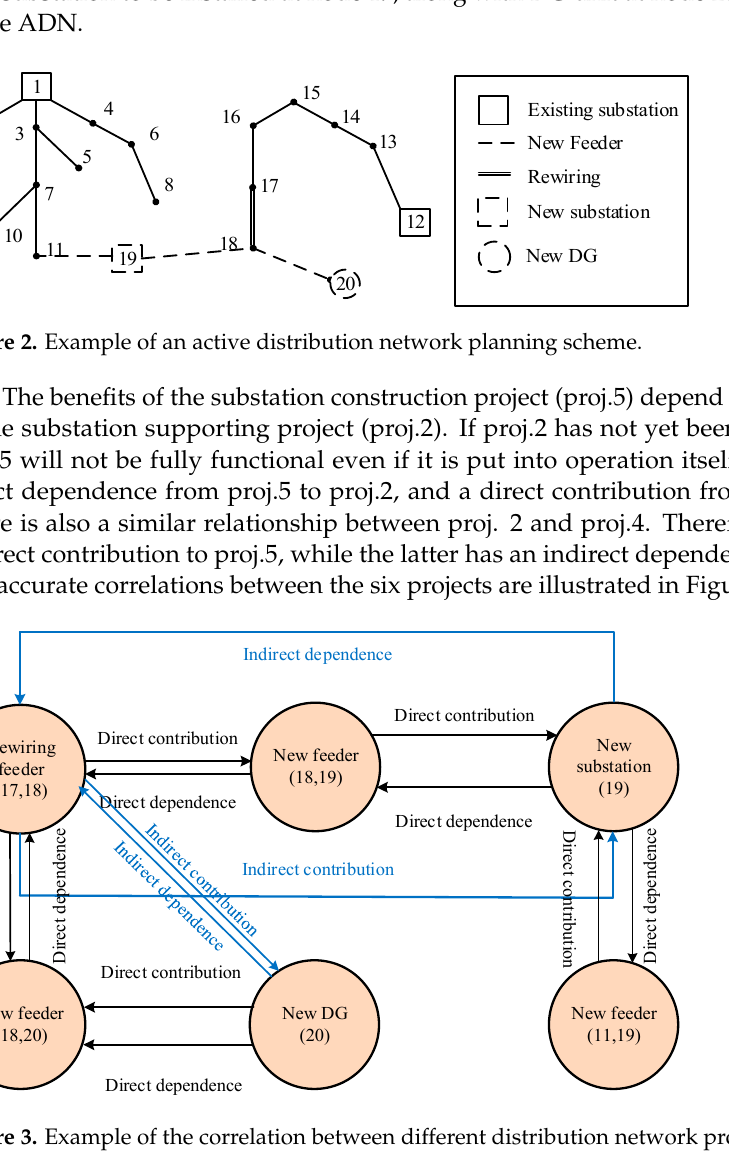
Figure 3. Example of the correlation between different distribution network projects. In addition, the actual distribution network planning requires the optimal planning of different voltage levels. Therefore, the possible correlations between cross-voltage ADN projects need to be taken into